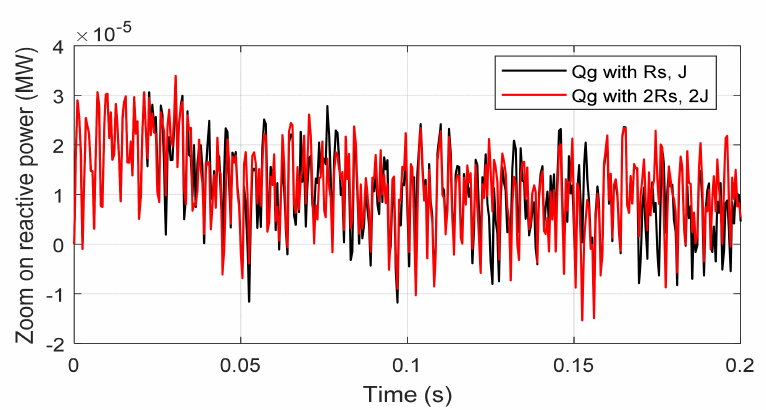
Figure 15. Reactive powers with parameter changes.